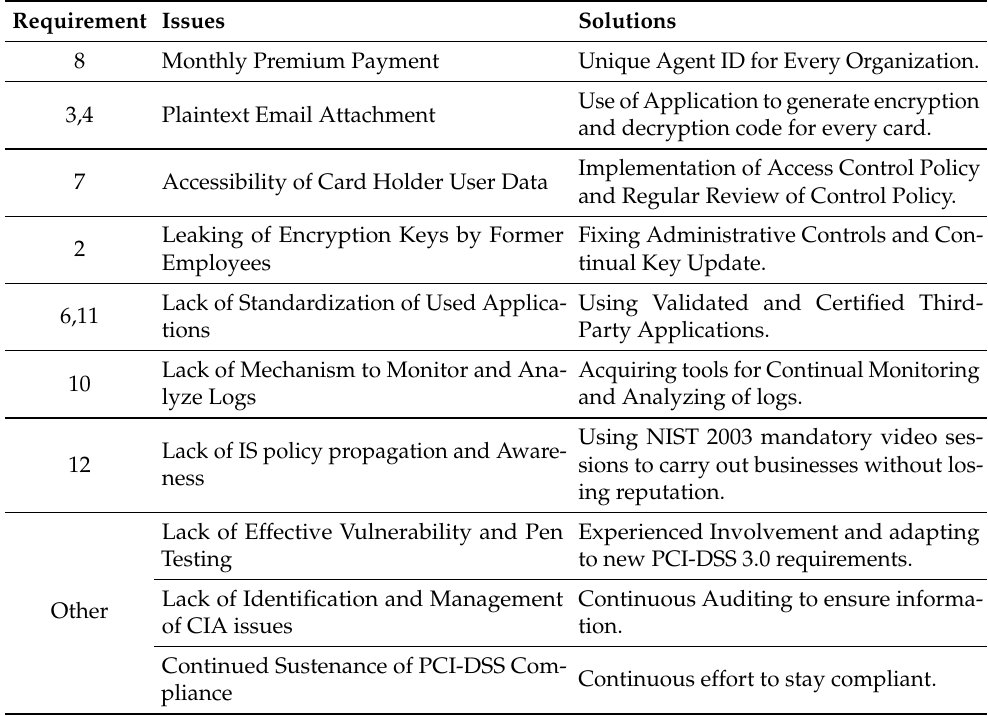
Table 2. Issues related to non-Compliance of PCI DSS requirements and their solutions